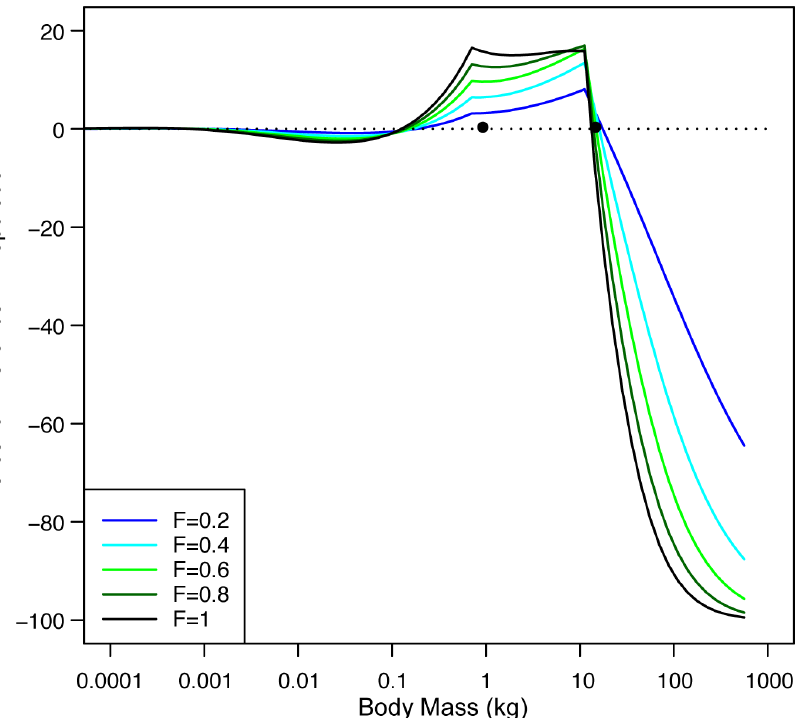
Figure 4. Change in fished ecosystem size structure relative to unfished ecosystem size structure. The percent change in ecosystem abundance by size between the unfished size structure and the fished size structure for F ranging from 0.2 to 1.0. The dots are located at 1 and 15 kg to indicate the size at entry to the fishery and the size of full recruitment.